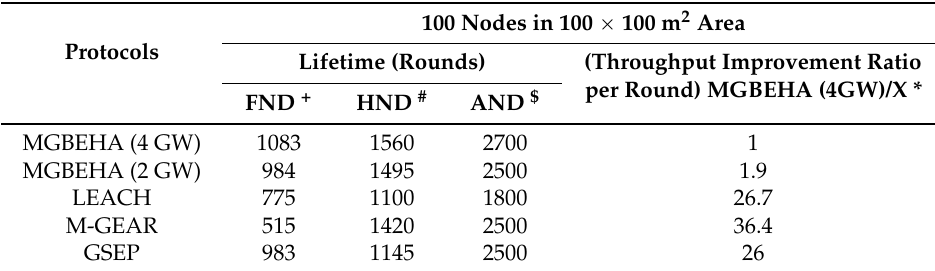
Figure 5. Number of nodes alive per round for different protocols in ( a ) 100 m × 100 m, and ( b ) 500 m × 500 m area. Table 4. Protocols performance of 100 nodes for 100 m × 100 m area.